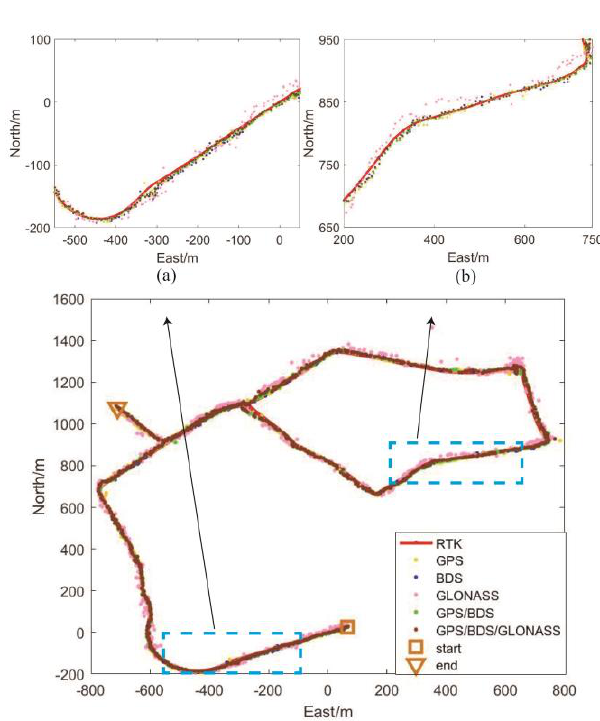
Figure 12 . Kinematic smartphone positioning results based on BDS, GPS, GLONASS satellite systems and their combinations. The blue points are the single-point positioning results of BDS. The yellow points are the single-point positioning results of GPS. The pink points are the single-point positioning results of GLONASS. The green points are the-single-point positioning results of the combination of GPS and BDS. The brown points are the single-point positioning results of the combination of GPS, BDS, and GLONASS. The red points are the RTK results of the kinematic car-borne experiment. The yellow square sign is the starting point of the trajectory during the kinematic experiment. The yellow triangle is the end of the trajectory during the kinematic experiment. Two fragments marked by blue boxes are zoomed in to show the differences in positioning results between BDS, GPS, and GLONASS satellite systems and their